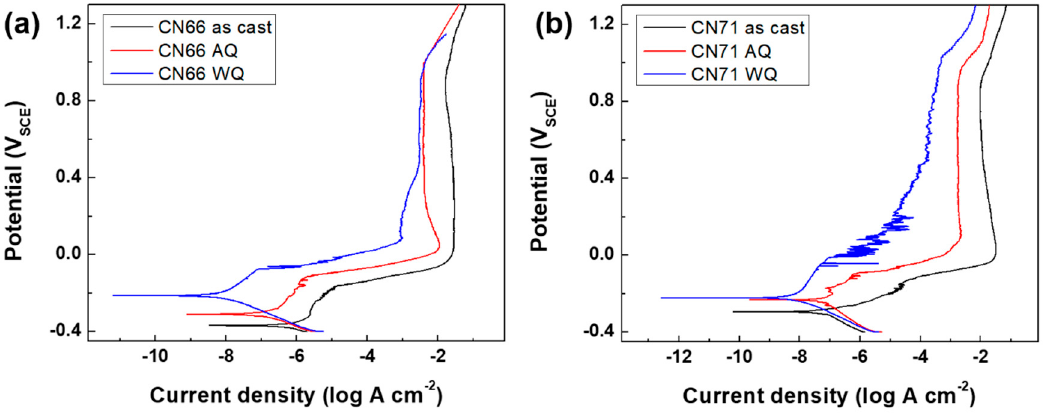
Figure 1. The polarization curves by potentiodynamic polarization tests of CN66 ( a ) and CN71 ( b ) with different heat treatment conditions (as-cast, solution treated and air-cooled (AQ), and water quenched (WQ)).